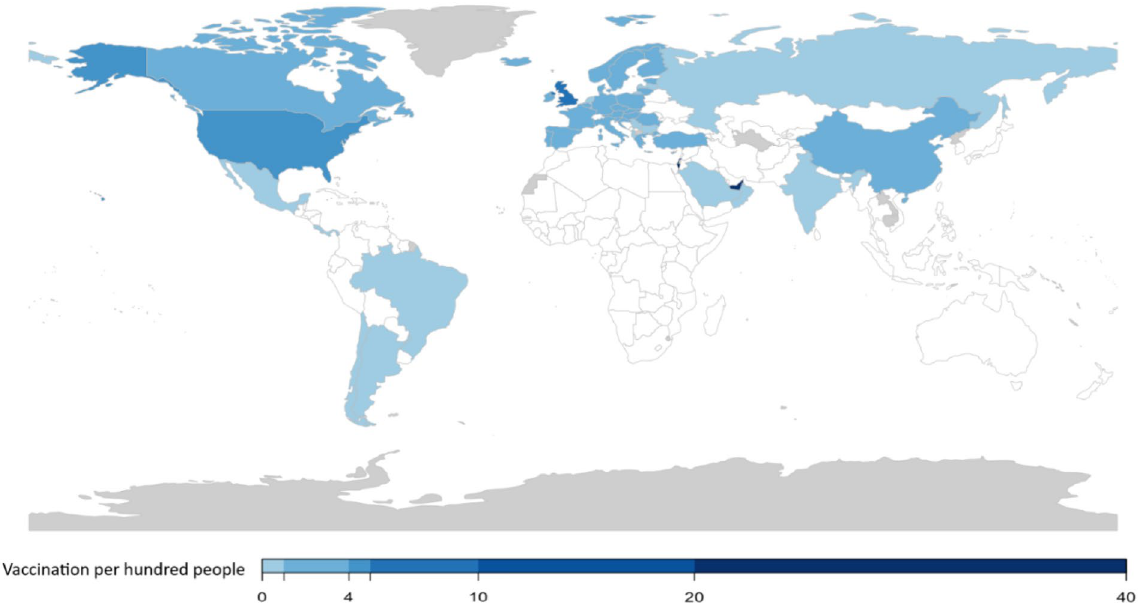
Figure 1. COVID-19 Vaccination per Hundred People Approximately One Month After the First Public COVID-19 Vaccination (by January 20, 2021). Darker blue shows higher vaccination rates per hundred people. Countries with no available data are shown in gray. The maps were generated using RStudio 4.0.2 (R Core Team, 2020). Downloaded from: https:// www. rstud io. com/ produ cts/ rstud io/ downl oad/.